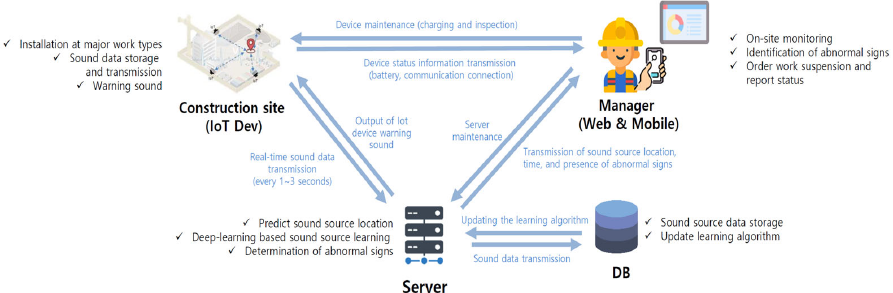
Figure 15. System